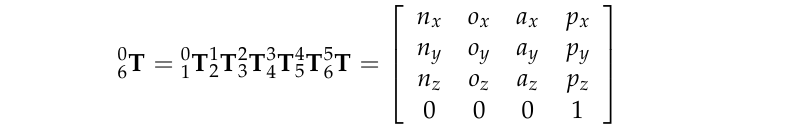
the end of the six DoF microstage gripper and the base is obtained, which is the total